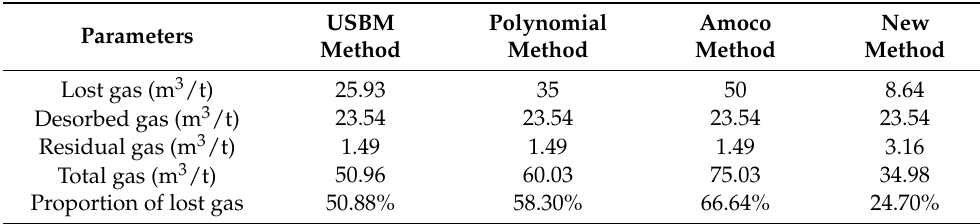
Table 4. Comparison of Results from Different Simulation